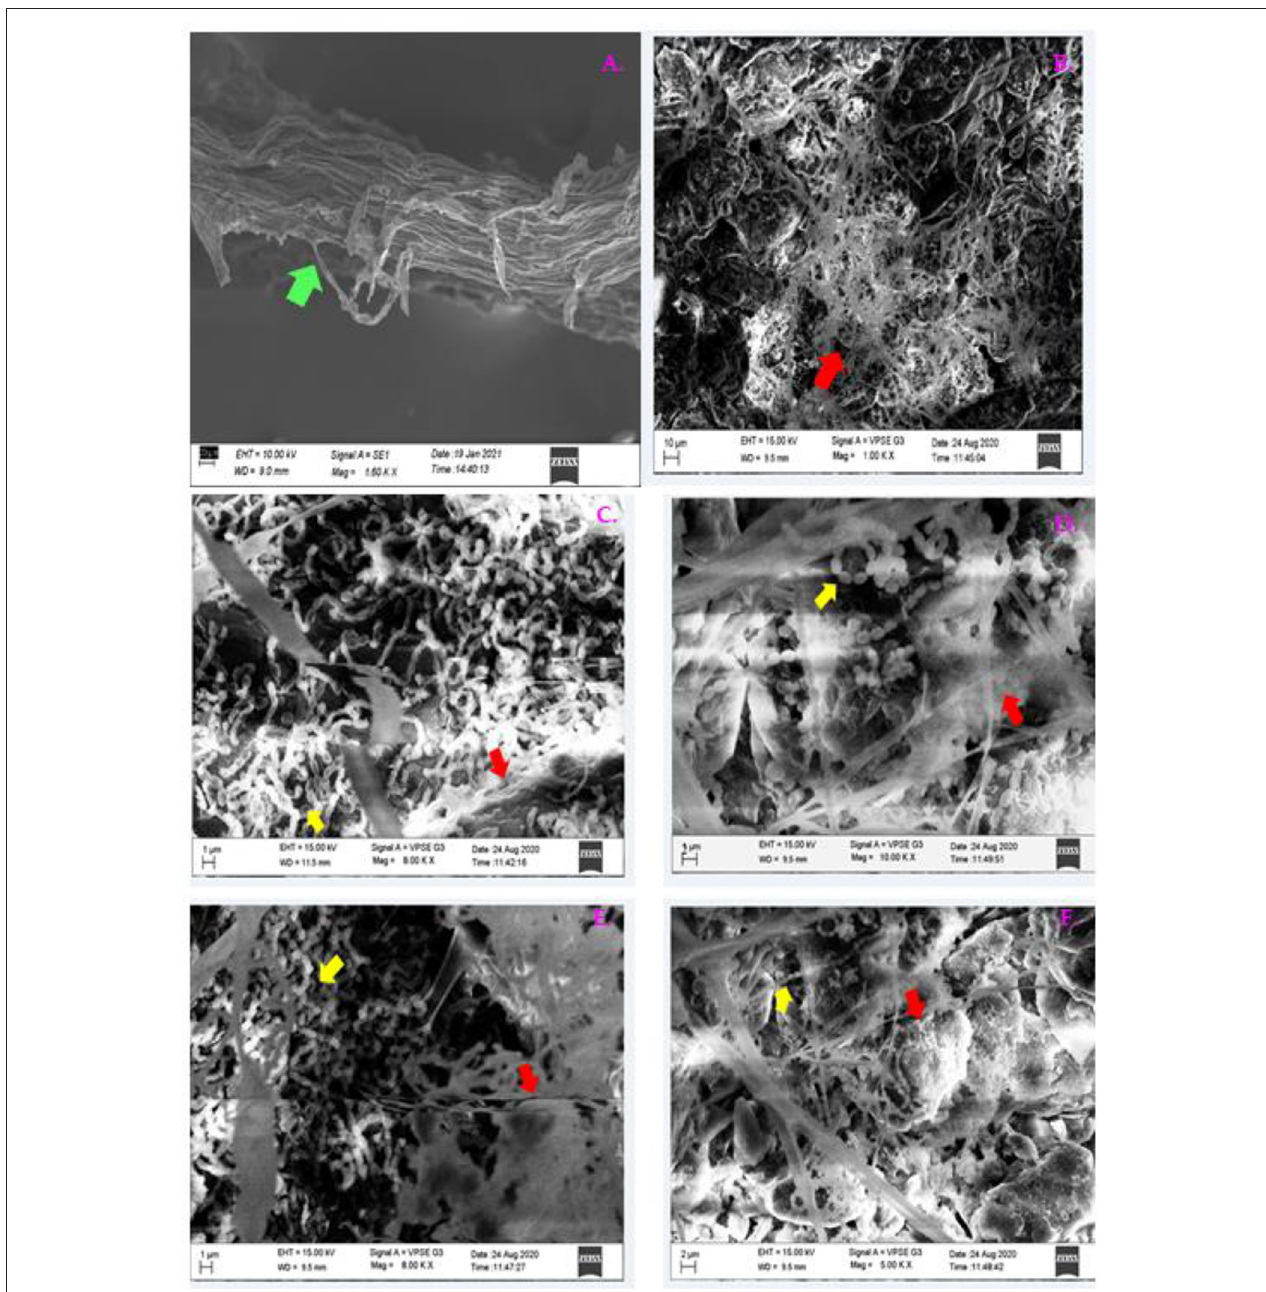
FIGURE 14 | The SEM micrographs of plant roots colonized by B1 and P1 on the tomato roots after 48h of pathogen invasion. Images were taken at the root tips; (A) CNT, (B) PC, (C) B1 at 1 µ m; (D) B1 at 2 µ m, (E) P1 at 1 µ m; (F) P1 at 2 µ m (Green arrow indicates root; red arrow shows pathogen invasion; and the yellow arrow indicates bacterial